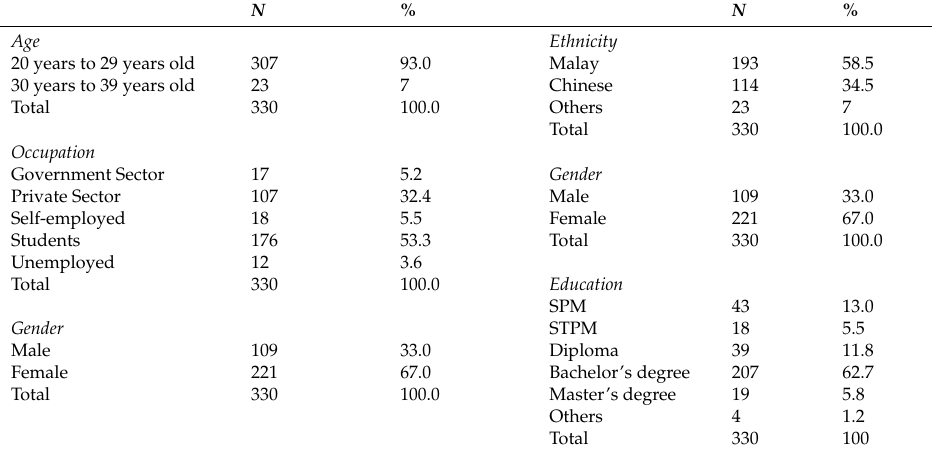
Table 3. Profile of the Respondents.